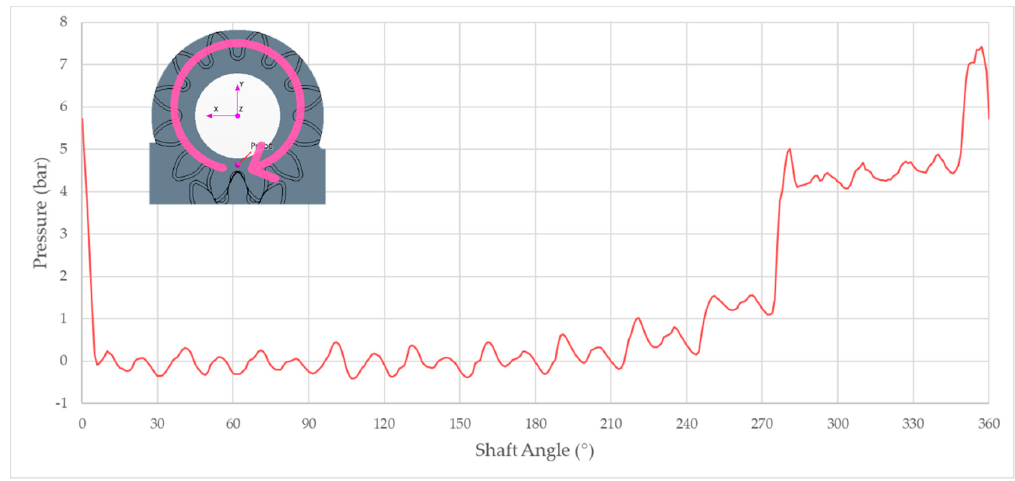
Figure 15. Pressure signal within the axial gap of the pump during an entire revolution of the driving shaft. On the top left corner, the initial position of the monitoring point is reported.